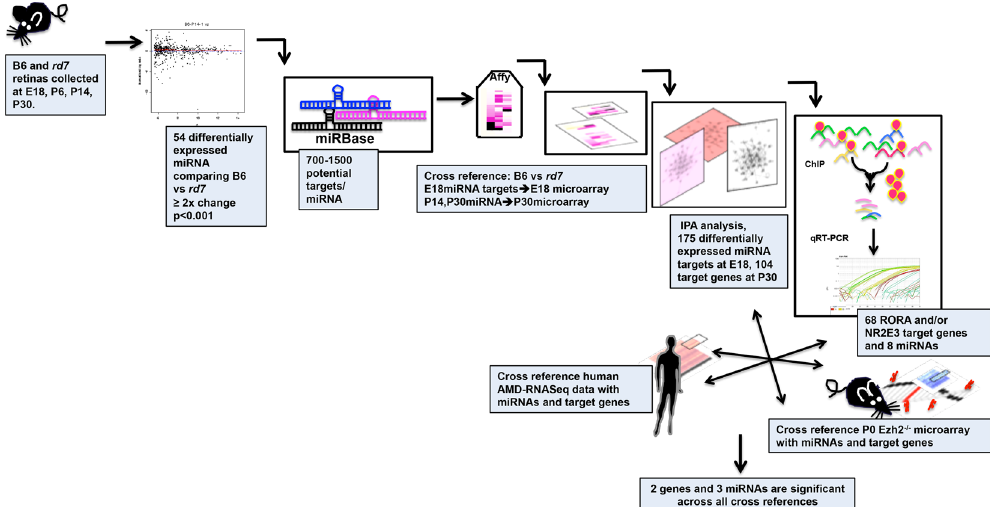
Figure 1. Comprehensive filtering strategy to identify multimodal regulation of miRNAs and their target genes. Step 1. 10 retinas per time point (E18, P6, P14, P30) were collected from B6 and rd7 . Step 2. miRNA microarray was performed on samples from step 1. 54 differentially miRNAS were identified with 2-fold change, P < 0.001. Step 3. Subsequent filtering analysis of miRNA expression data was performed using BRB Array Tools along with Stanford Statistical Analysis of Microarrays (SAM) and evaluated using miRBase to identify their potential target genes. Step 4. miRNA targets were then cross-referenced with E18 microarray and P30 rd7 microarray data. Steps 5, 6. Genes that were found to be statistically significant were analyzed using Ingenuity Pathway analysis to algorithmically generated gene networks in which the default cutoffs identify those genes that were significantly differentially regulated in the network. Step 7. Genes that were identified through the networks were screened for the nuclear receptor-binding site of Nr2e3 and RORA and further analyzed by chromatin immunoprecipitation. A total of 68 genes were direct targets of RORA and/or Nr2e3 as well as 8 miRNAs (out of the 54 differentially expressed miRNAs identified). The results obtained were then cross-referenced to AMD- RNAseq data and microarray data from the epigenetic factor Ezh2. This filtering strategy allowed us to identify 2 genes (Ell2 and Entpd1) as well as 3 miRNAs (mir466, miR1187 and miR710) that are regulated by epigenetic factors and nuclear hormone receptors and are associated with AMD